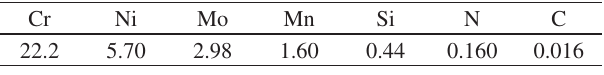
Table 1. Chemical composition of the investigated steel